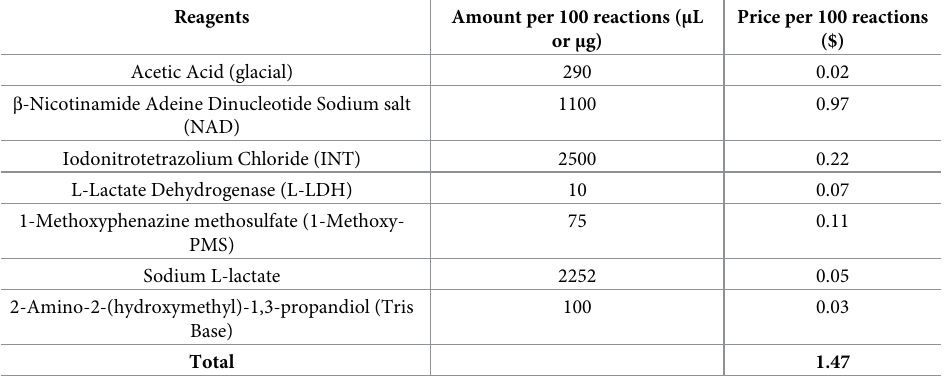
Table 1. Cost of the reagents of custom L-lactate